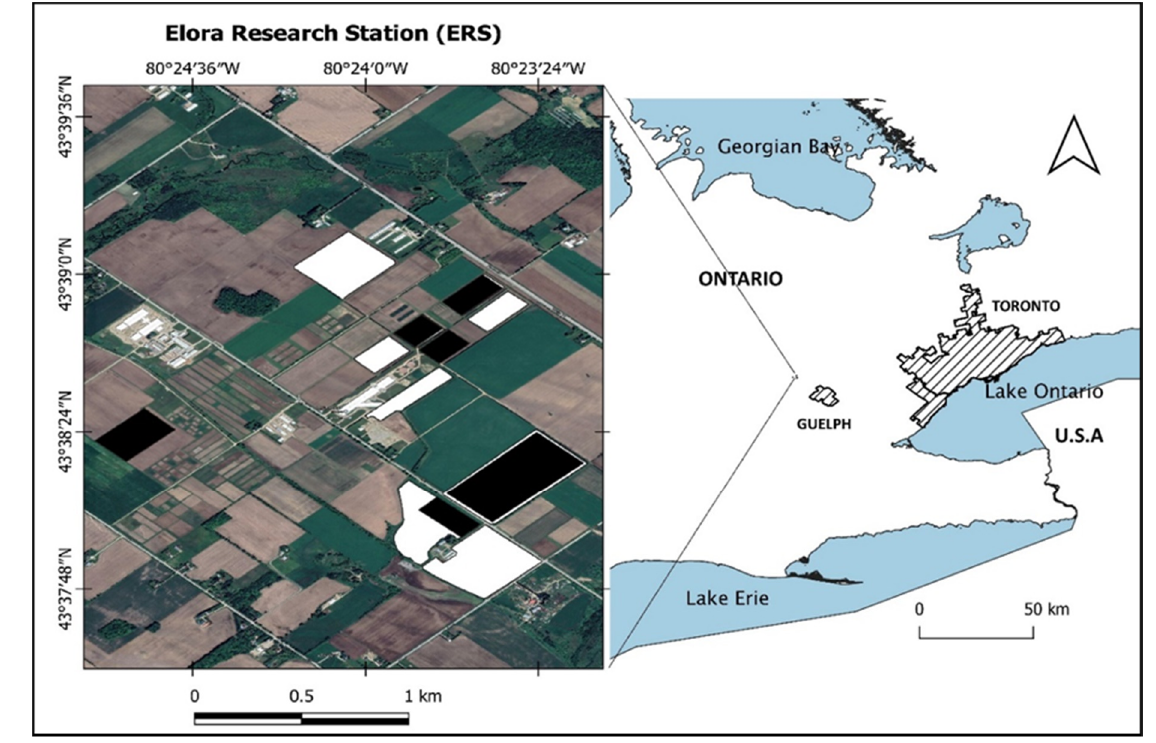
Figure 1. The location of the Elora Research Station (ERS) in Ontario, Canada. The white polygons on the left image indicate the fields of study in May, and the black polygons indicate the November fields.